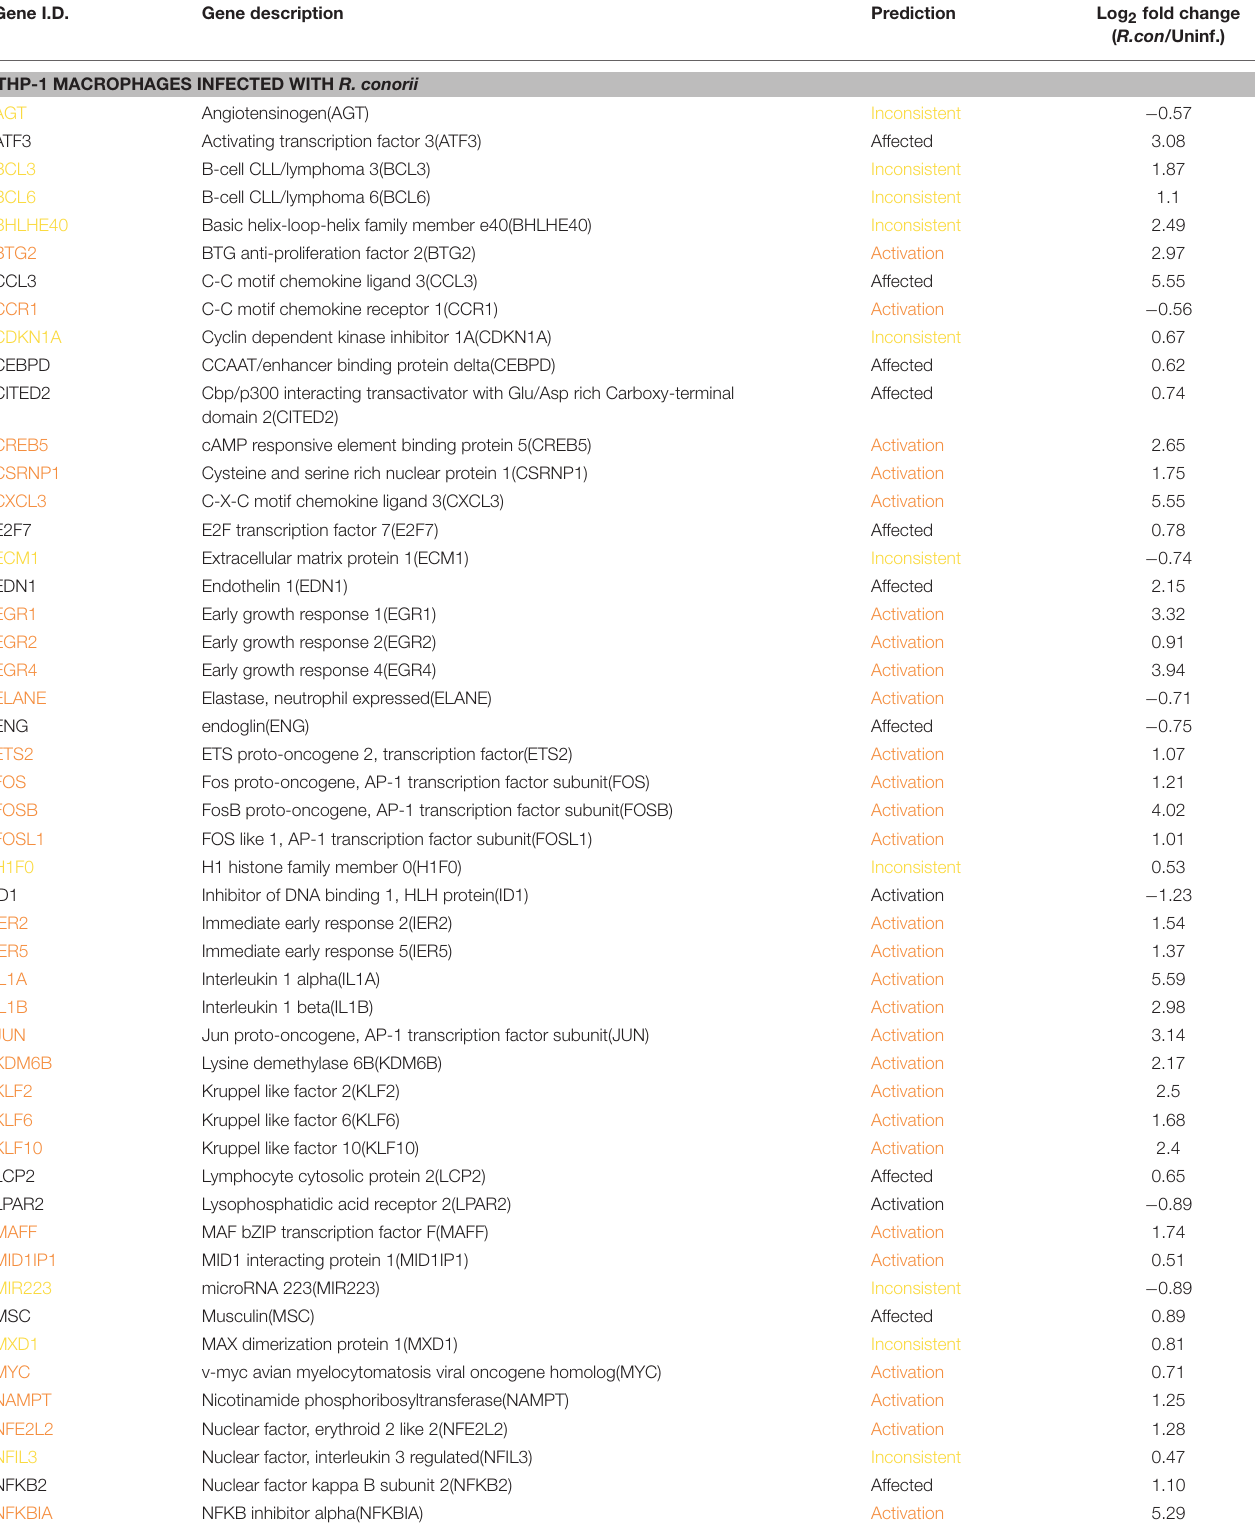
TABLE 5 | Predicted contribution of DE genes in R. conorii - and R. montanensis -THP-1 macrophages for transcription based on “Diseases and Functions” category by IPA. Gene I.D. Gene description Prediction Log 2 fold change